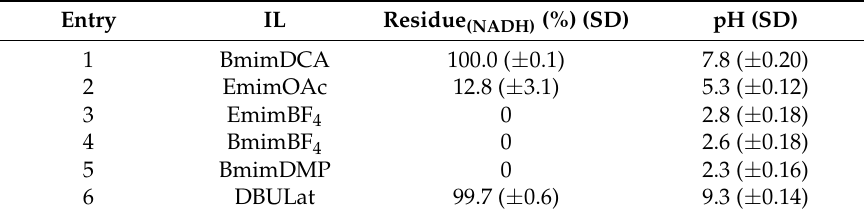
Figure 1. Study of the degradation of NADH in the presence of BmimBF 4 . ( A ) Temperature-course plot (time interval: 10 min); ( B ) Time-course plot of degradation at 37 °C; General conditions: NADH (1.4 mg, 2 μmol); BmimBF 4 (2 μL, 5.0 equiv.); H 2 O (2 mL).